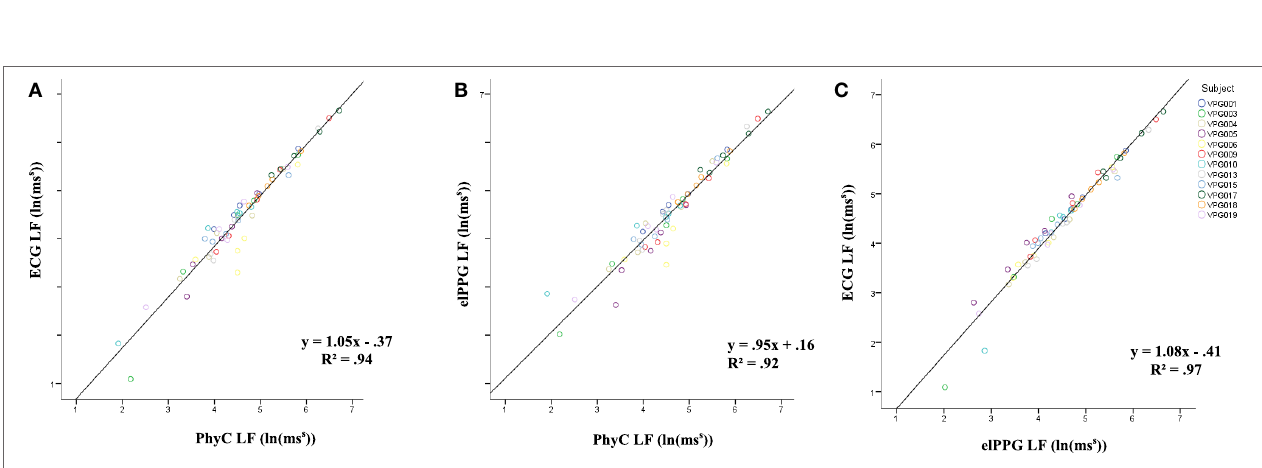
FigUre 9 | Scatter plots between sensors for LF, color coded by participant. (a) PhysioCam (PhyC) vs electrocardiogram (ECG). (B) PhyC vs elPPG. (c) elPPG vs ECG.